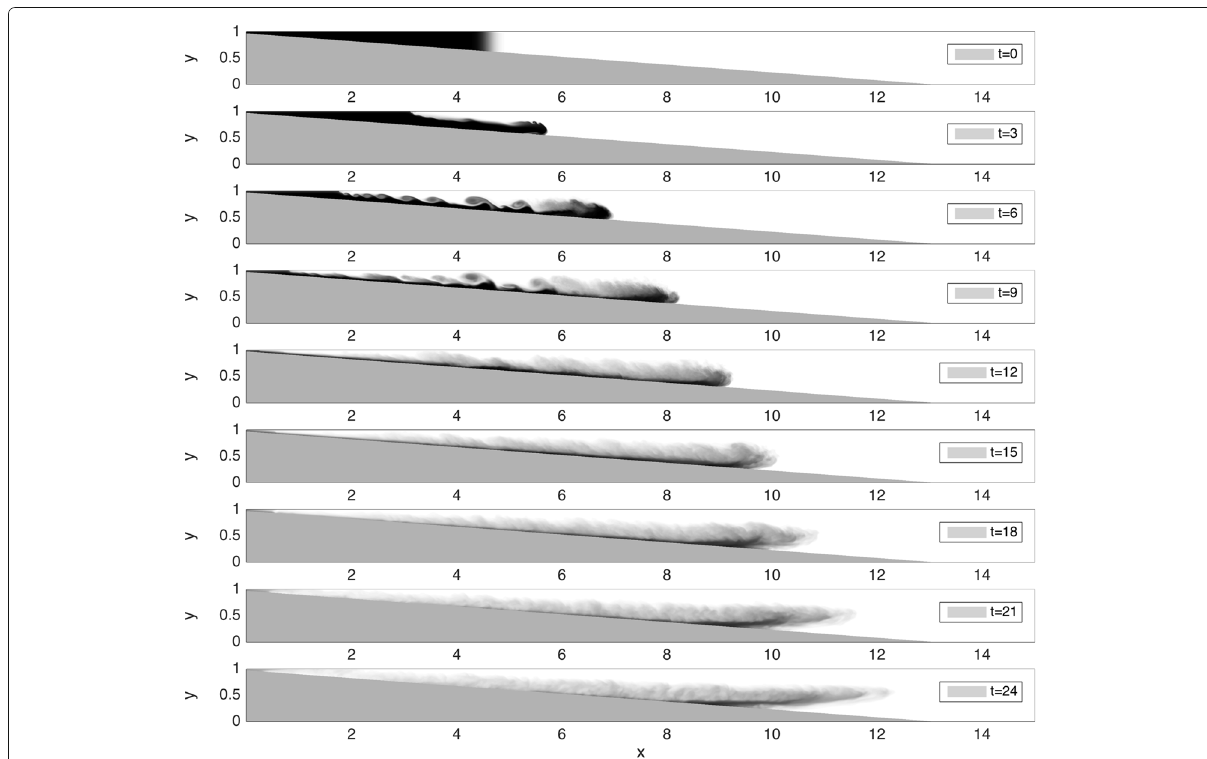
Fig. 2 Spanwise averaged particle concentration pseudo-color plot for various times ( Re = 15000, v s = 0.001, N = 2.11, m = 0.0744). This represents the case of a turbidity current with non-zero settling velocity moving down a uniformly stratified ambient. The density of the lock is initially larger than the ambient fluid outside of the lock such that the current starts moving downslope upon release. It then encounters region of denser and denser saline ambient, until its density reaches that of the ambient and it intrudes horizontally. The flow is 2D at very early stages but quickly grows unstable under the effect of a spanwise instability at the head. This leads to the breakdown of 2D vorticies into much smaller 3D mixing structures at the head and all along the body of the current at the interface with the